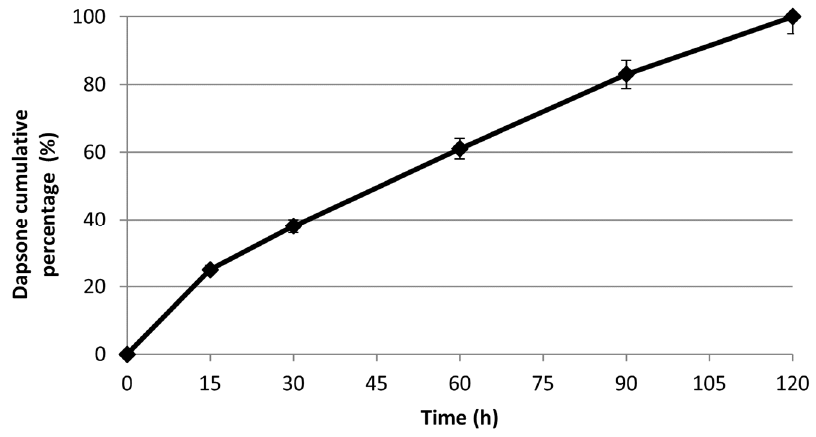
Figure 5. The in vitro cumulative release of Dapsone from the DES in pH 7.4 at 34 °C.